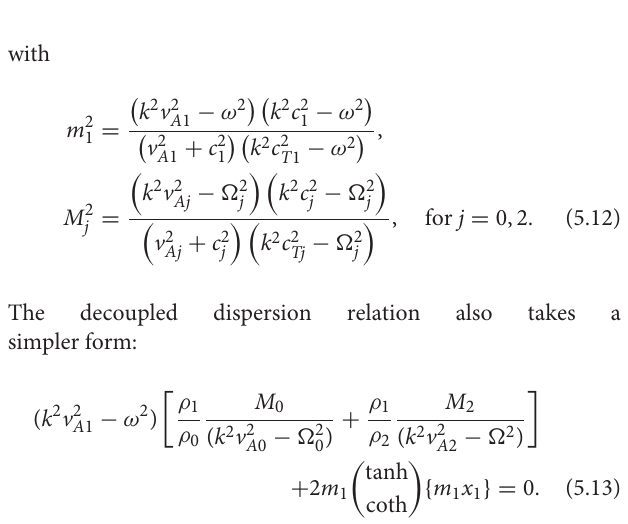
FIGURE 10 | The equilibrium configuration for a steady and magnetized slab in an asymmetric non-magnetic environment.